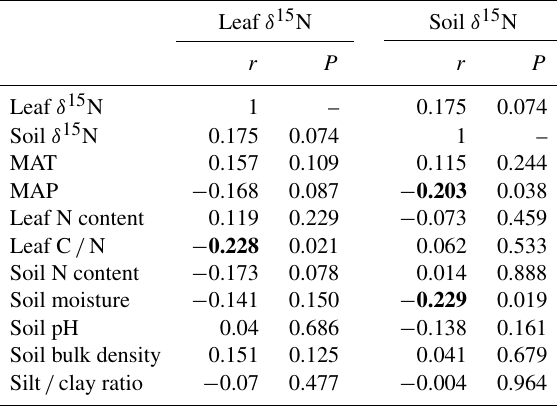
Table 4. Correlation analyses between leaf or soil δ 15 N and influ- ential factors on the south slope of Tian